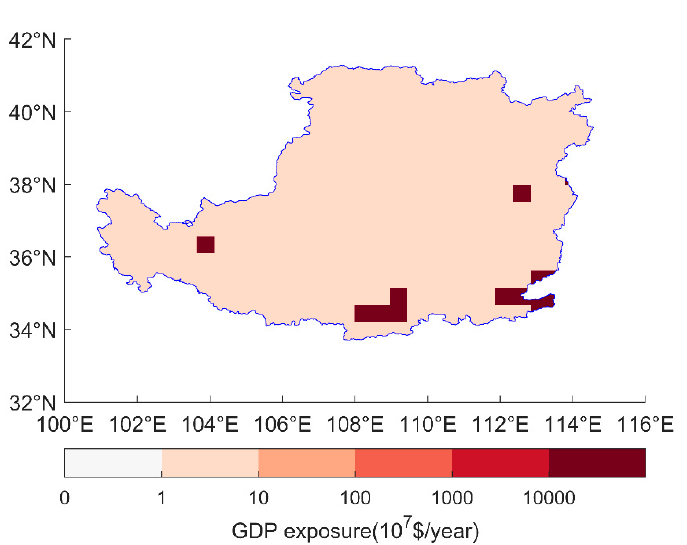
Figure 8. Spatial distribution of the average annual GDP exposure to extreme precipitation events on the Loess Plateau for 1.5 ◦ C global